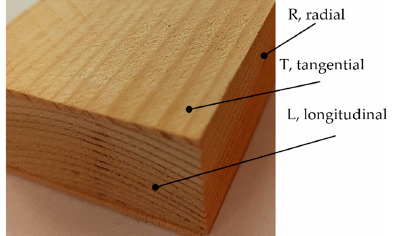
Figure 1. The clear test specimen oriented according to the main cross-sections in the stem. After the primary cut, the planks were dried at a temperature lower than 60 °C. The test samples were cut and then conditioned at a temperature of 20 ± 2 °C and relative humidity of 65 ± 3% for three months. The moisture content of the test samples immedi- ately before the hardness measurements was 10 ± 0.5%, and their average densities are given in Table 1. Table 1. Wood species names and average densities of test samples used. Species